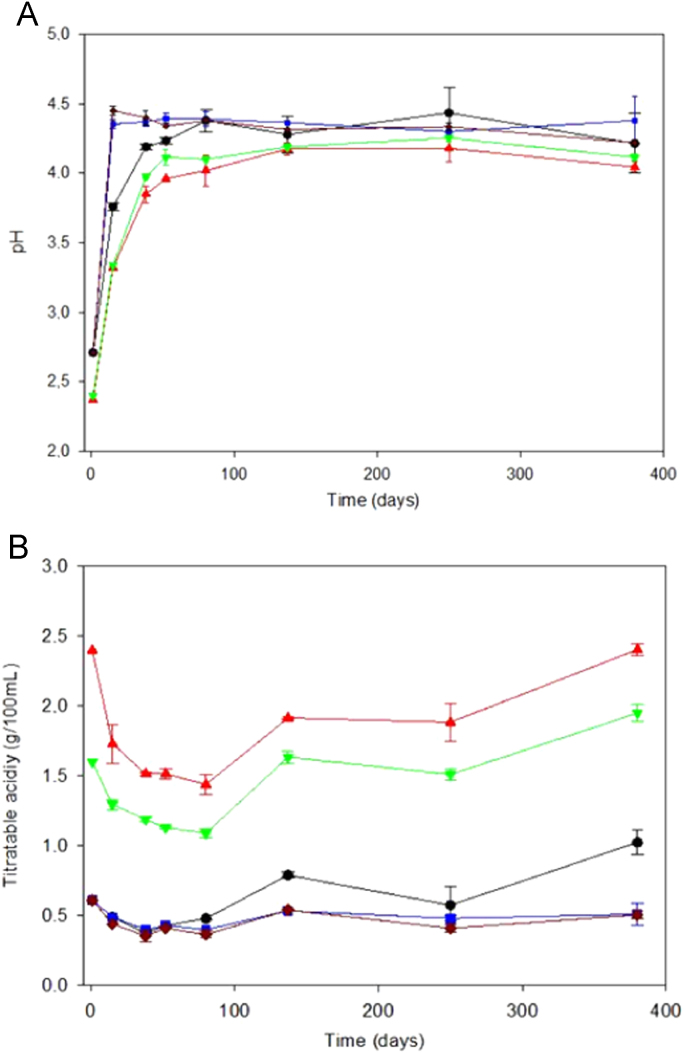
Changes in pH (panel A) and titratable acidity (panel B) over time, according to treatments (Image 1Image 2Image 3Image 4 and Image 5). CC, control of acidified cured olives; CI, highly acidified cured olives; CII, intermediate acidified cured olives; CT, control of traditional (cracked) olives; RT, traditional olives, cracked after 72 h of exposure to air.